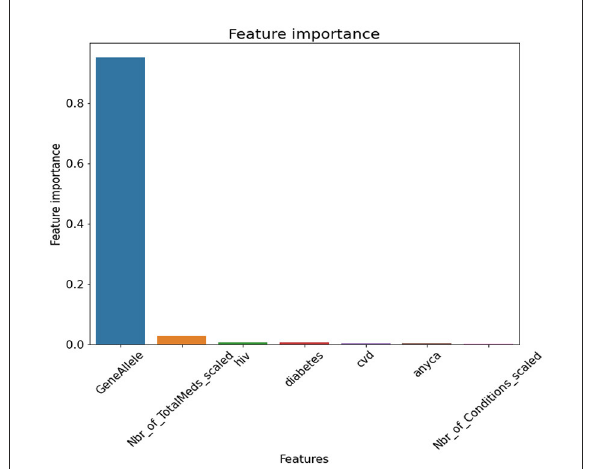
FIGURE6 Feature Selection for Final Model. GeneAllele = Variable for presence/absence of gene contraindicated with medication, Nbr_of_TotalMeds_scaled = scaled variable for number of total medications, hiv = presence/absence of hiv, diabetes = presence/absence of diabetes, cvd = presence/absence of cardiovascular disease, anyca = presence/absence of cancer, Nbr_of_Conditions_scaled = number of total disease conditions.